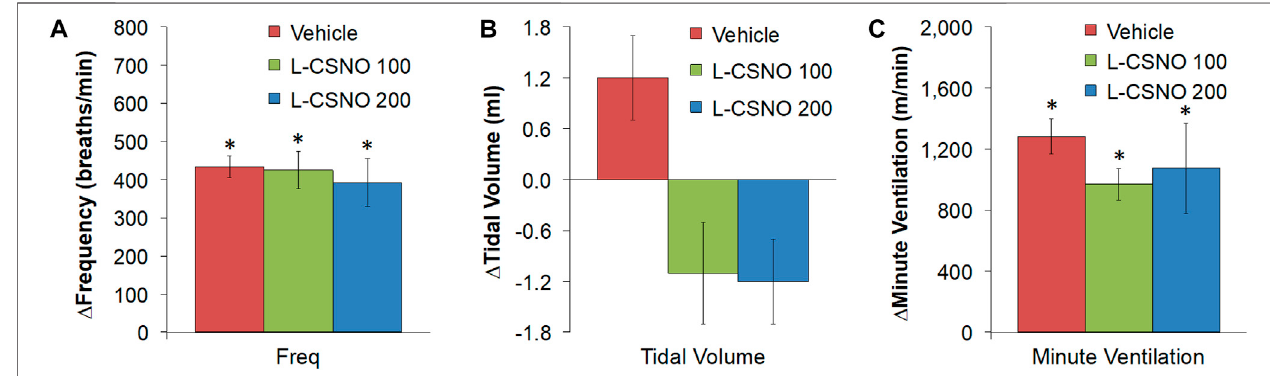
FIGURE 10 | Total arithmetic changes in frequency of breathing (A) , tidal volume (B) , and minute ventilation (C) over the 9-min period following the injection of naloxone methiodide (1.5 mg/kg, IV) in rats receiving infusion of vehicle (20 μ l/min, IV), L-CSNO 100 (S-nitroso-L-cysteine, 100 nmol/kg/min, IV), or L-CSNO